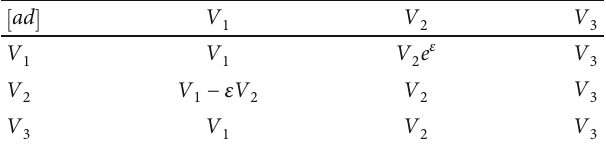
Table 6: Adjoint